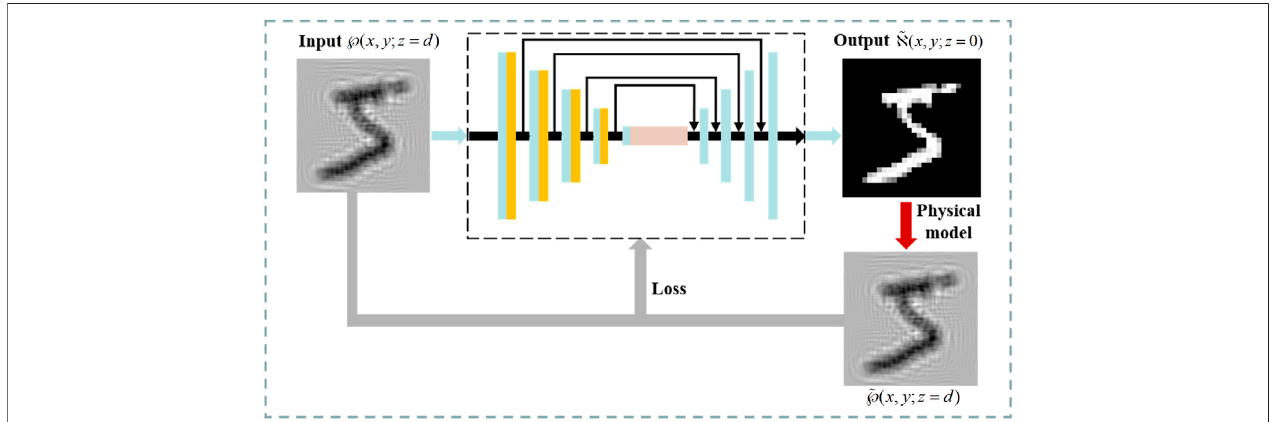
FIGURE 1 | Flowchart of the PhysNet-AH method for acoustic hologram reconstruction. Measured acoustic fi eld intensity ℘ ( x , y ; z (cid:2) d ) from the hologram at the distanceofdistheinputofthenetwork.Theoutputofthenetworkistheestimatedtargetobject ~ ℵ ( x , y ; z (cid:2) 0 ) ,whichisthennumericallypropagatedbyphysicalmodelH tosynthesizetheacoustic fi eldintensity ~ ℘ ( x , y ; z (cid:2) d ) .Themeansquareerror,l 1 loss,andstructuresimilarlossbetween ℘ ( x , y ; z (cid:2) d ) and ~ ℘ ( x , y ; z (cid:2) d ) arecalculatedas the loss to optimize the model.